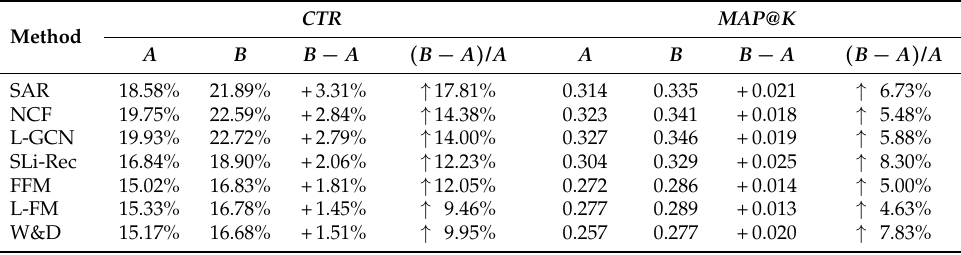
Table 2. The results of A/B experiments for visual information on the Netflix dataset ( A : single image; B : multiple